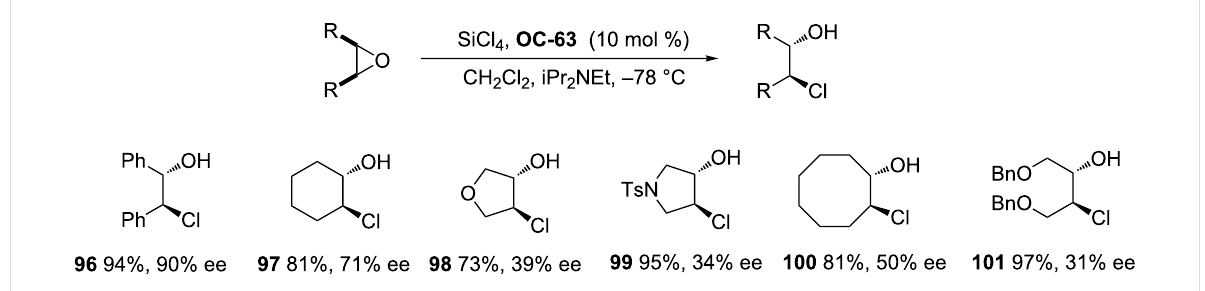
Scheme 16: The enantioselective desymmetrization of meso -epoxides in the presence of OC-63 .